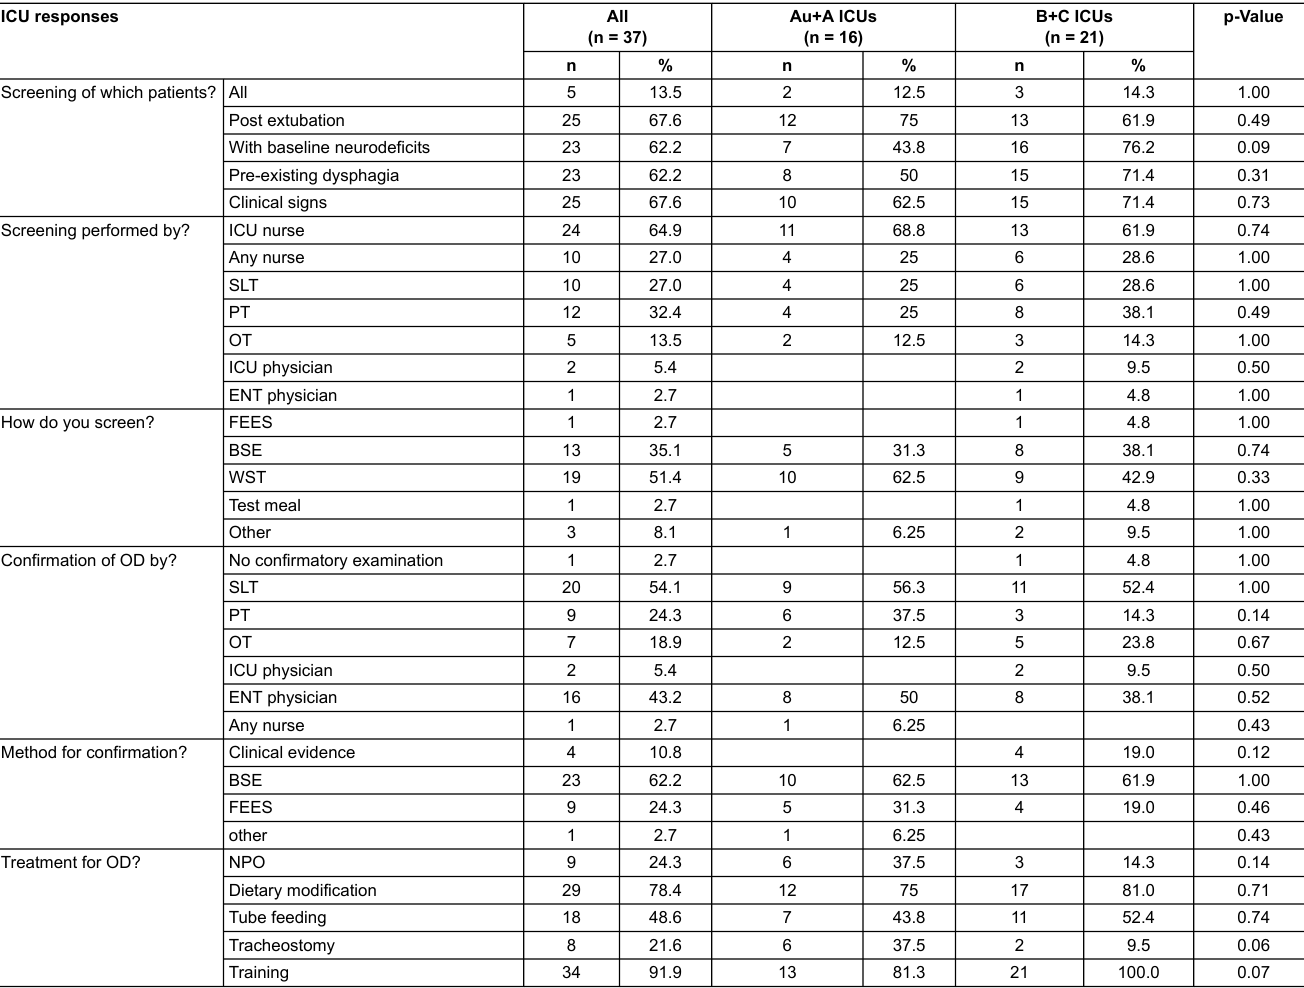
Table 2: Responses regarding the screening, confirmation and treatment of dysphagia in all participating ICUs, as well as the methods used for assessing OD. ICU